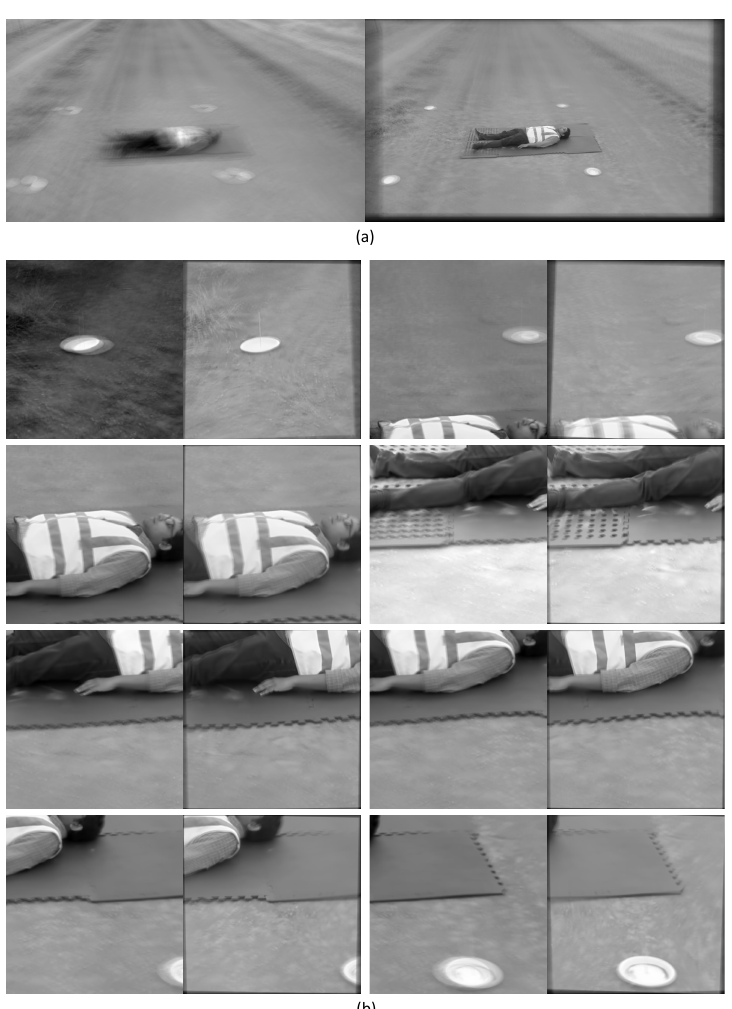
Figure A1. Some selected mean images after the video stabilization of video A1. ( a ) The raw input mean (left) and corrected sequence mean (right) of video A1. The corrected sequence mean is calculated after the first level of stabilization. ( b ) Mean images after the second level of stabilization. Each pair of images represents the raw input mean (left) and corrected sequence mean (right) of a randomly selected tile video of